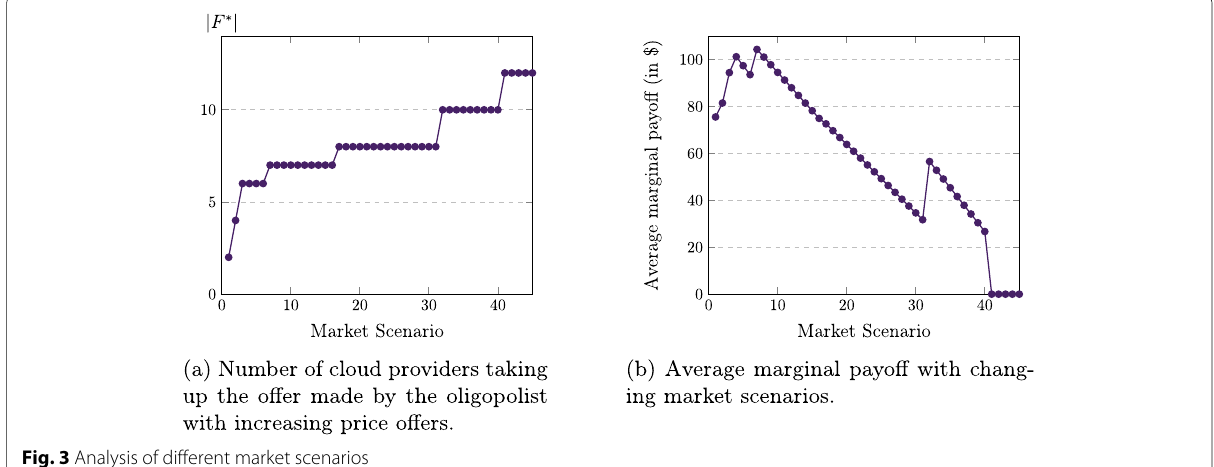
Fig. 3 Analysis of different market scenarios